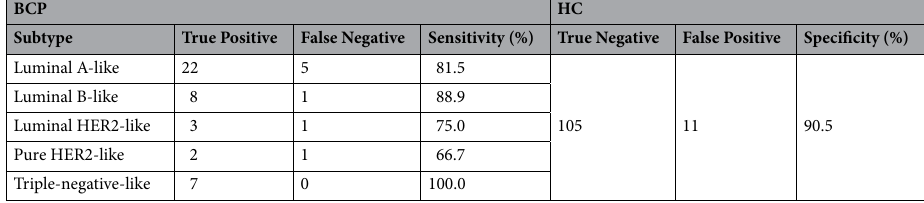
Table 6. The results for each histological subtype when applying the model to the external validation set. BCP breast cancer patient, HC healthy